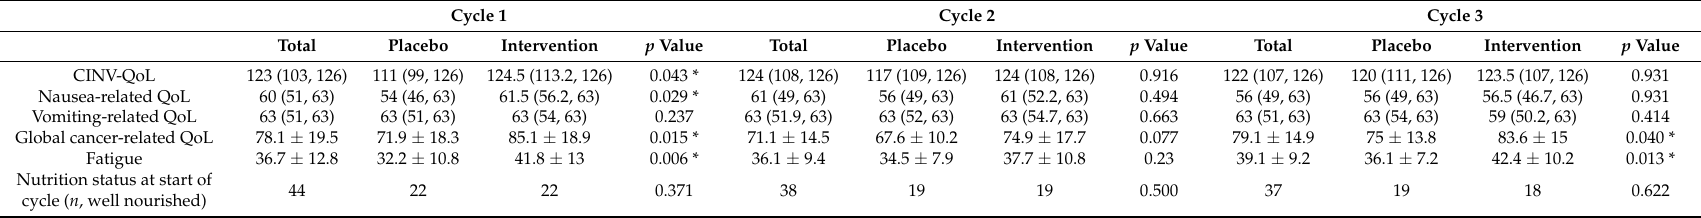
Table 2. Cancer- and chemotherapy-induced nausea and vomiting (CINV)-related quality of life (QoL), cancer-related fatigue, and nutrition status. Cycle 1